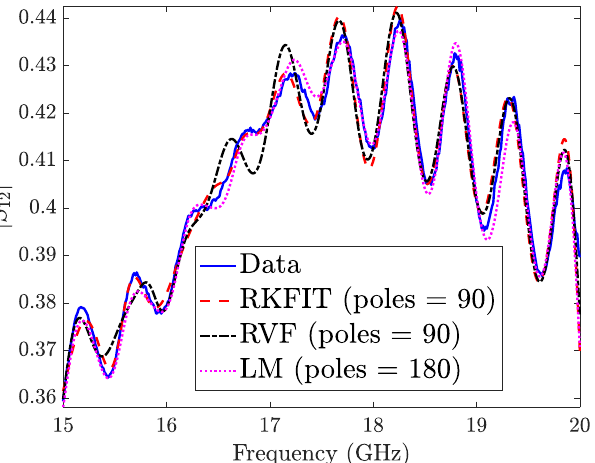
Figure 4. Comparison of RKFIT with RVF and LM models with given data for | S 12 | of Section 3.1